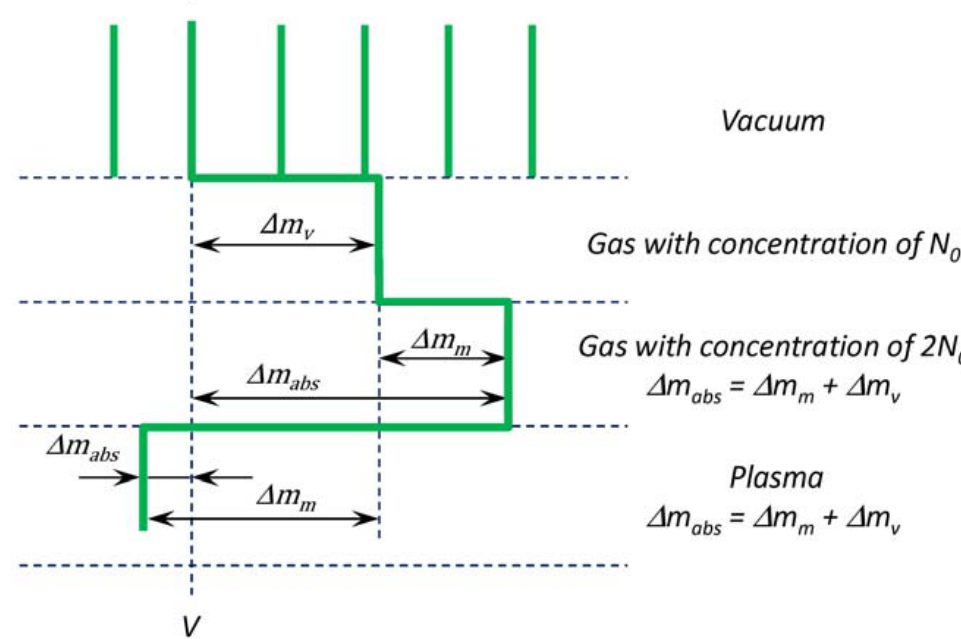
Figure 4. Hypothetical trend of the interference fringes paths in different situations: in vacuum, in gas with various concentrations, and in plasma .